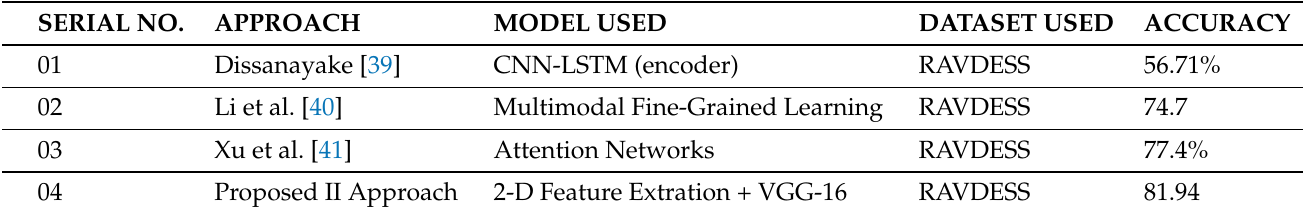
Table 1. Comparative study.